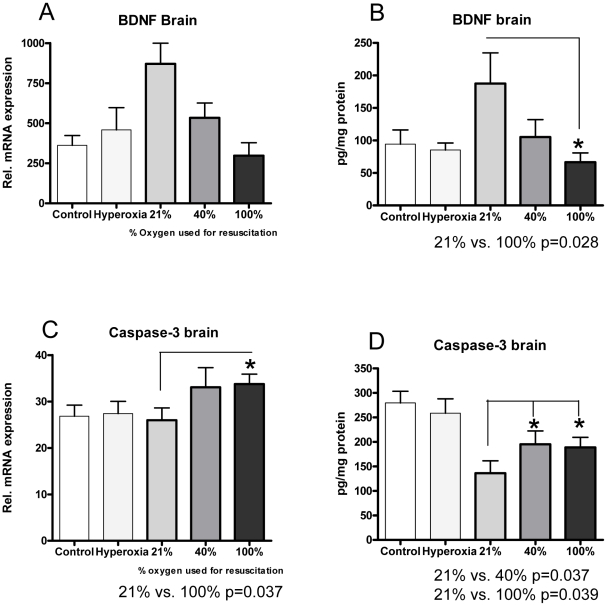
BDNF and caspase-3.
A: For BDNF, the relative mRNA expression for each group was: 21% (n = 10) 914.6 (909), 40% (n = 10) 585.1 (642.8), 100% (n = 10) 466.5 (412.3) p = 0.15 for 21% vs. 100% due to great inter-animal variability.The hyperoxia group (n = 10) was equal to the control group (n = 6); 391.7 (374) vs. 406.2 (320). B: Immunohistochemistry (ELISA). BDNF (pg/mg protein) was 21% (n = 10) 187.5 (149.1), 40% (n = 12) 105.2 (93.3), 100% (n = 10) 66.4 (45.2). * p = 0.028 for 21% vs. 100%. The hyperoxia group (n = 11) was equal to the control group (n = 6); 85.3 (36.0) vs. 94.4 (53.5). C: For caspase-3, the relative mRNA expression for each group was: 21% (n = 10) (26.0 (8.4), 40% (n = 12) 34.0 (14.5), 100% (n = 9) 33.7 (6.5). *p = 0.037 for 21% vs. 100%. The hyperoxia group (n = 11) was equal to the control group (n = 6); 27.4 (8.7) vs. 31.2 (11.7). D: Immunohistochemistry (ELISA). Caspase-3 (pg/mg protein) was 21% (n = 10)136.1 (80.6), 40% (n = 12)195.1 (94.6), 100% (n = 10)188.9 (64.8). * p = 0.037 for 21% vs. 40% and *p = 0.039 for 21% vs. 100%. The hyperoxia group (n = 11) was equal to the control group (n = 6); 258.7 (97.5) vs. 279.6 (58.0). Caspase-3 expression levels correlated negatively with BDNF expression levels (r = −0.49, p = 0.024). Values are expressed as mean (±SD), *p<0.05.